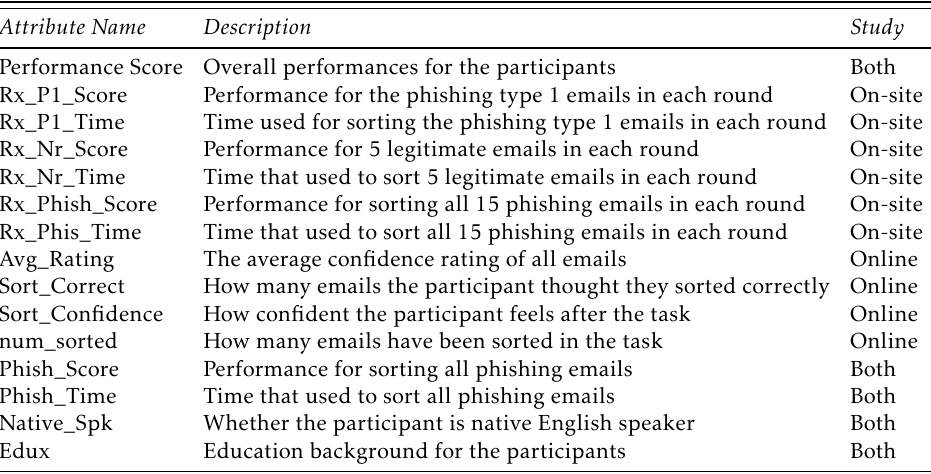
Table 3. Example of Attributes Used In Each